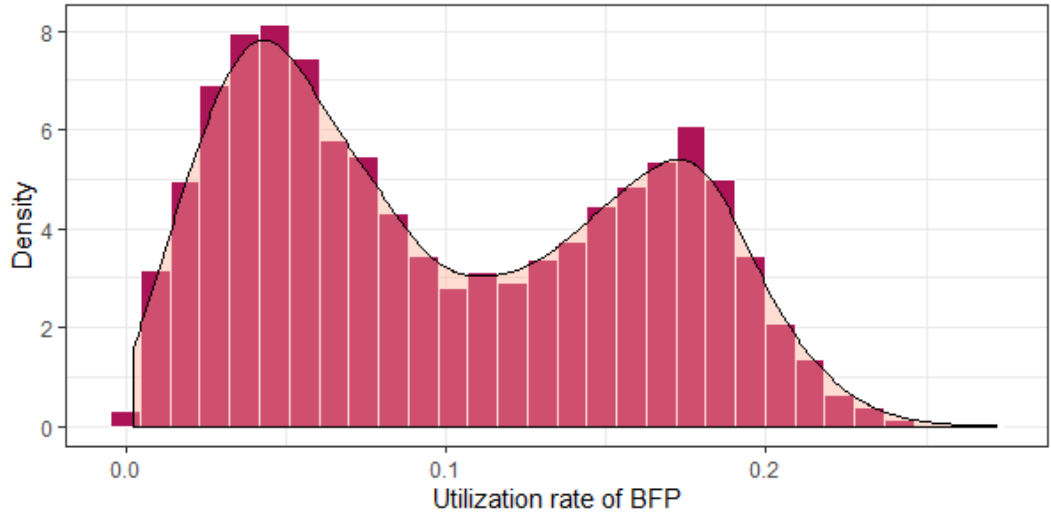
Figure 3. Distribution of the average of BFP city utilization rate. Source: prepared by the